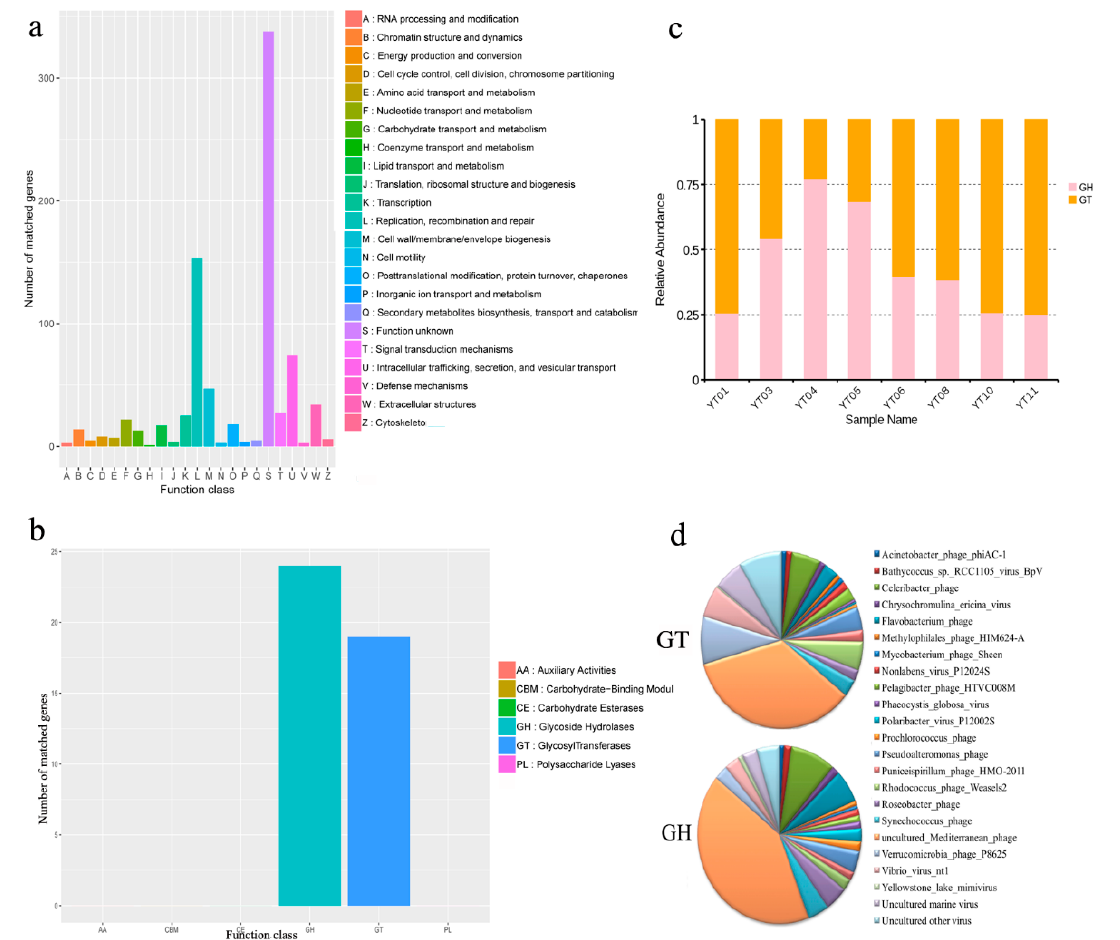
Figure 6. Overview of functional annotation algal bloom sample viromes. ( a ) Composition of predicted functional genes of sample viromes. ( b ) Annotation of viral carbohydrate-metabolism-related ORFs in the CAZy database. ( c ) Relative abundance of GH and GT in different algal bloom samples. ( d ) The relative contributions of viral species to GH and GT genes.